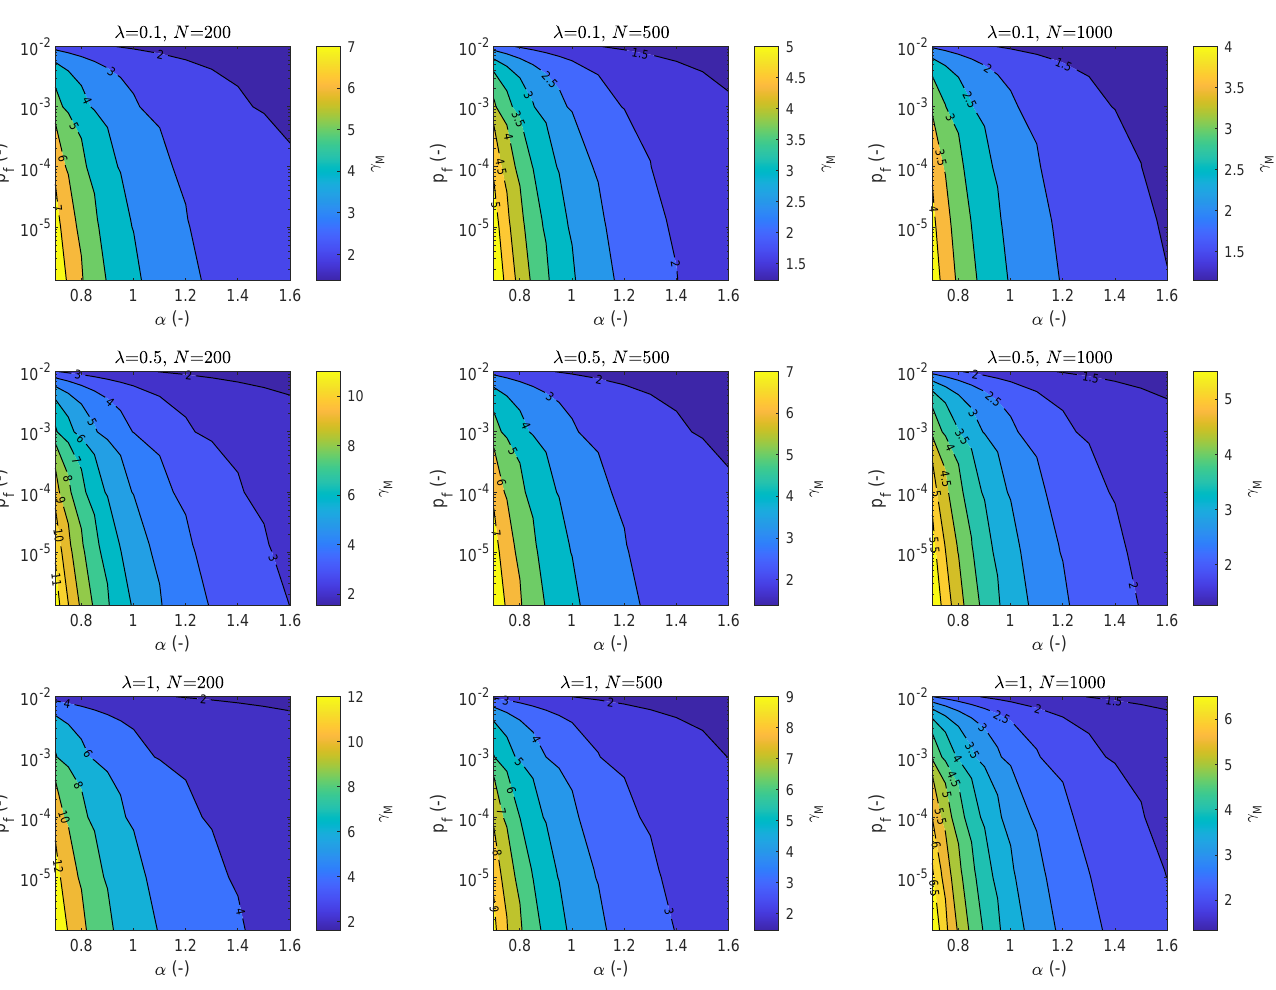
Figure A1. Partial safety factor related to the mass, γ m , for variable failure probabilities considering a reference block mass having a return period T k = 50